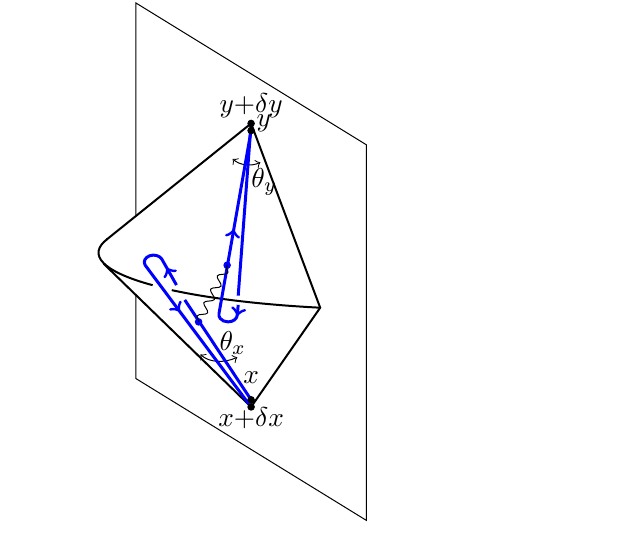
Figure 3 . Graviton exchange contribution to the out-of-time-order correlator in the eikonal limit δx , δy → 0